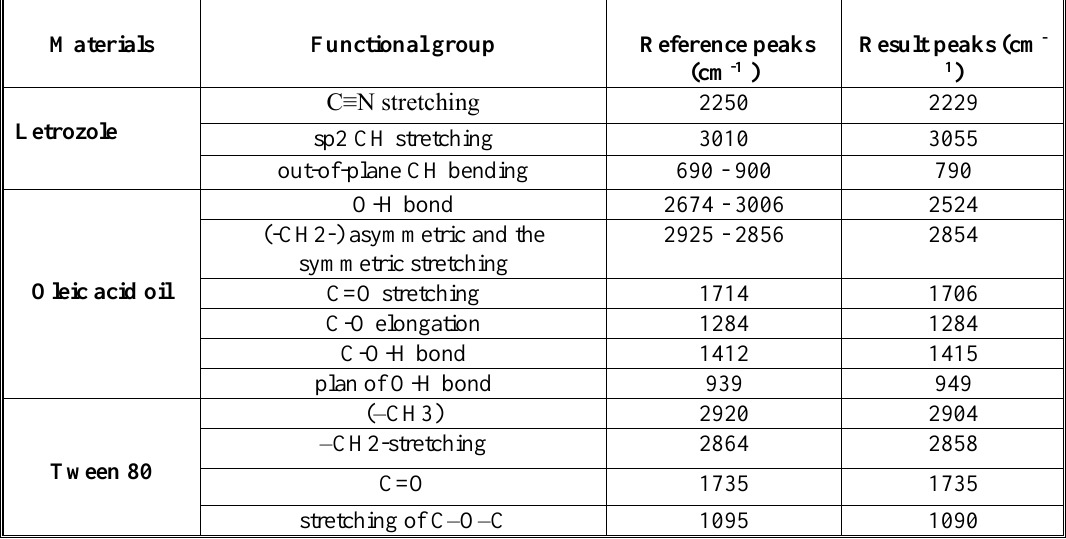
Table 1. The FT-IR characteristic Functional Groups of Materials